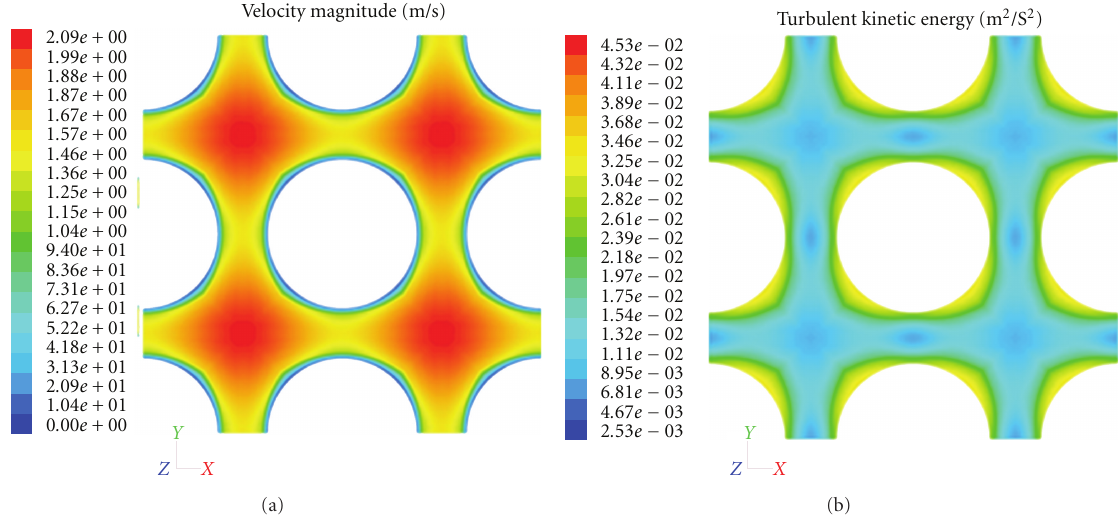
Figure 4: Contour of velocity and turbulent kinetic energy at the outlet for pure water at Re = 20 × 10 3